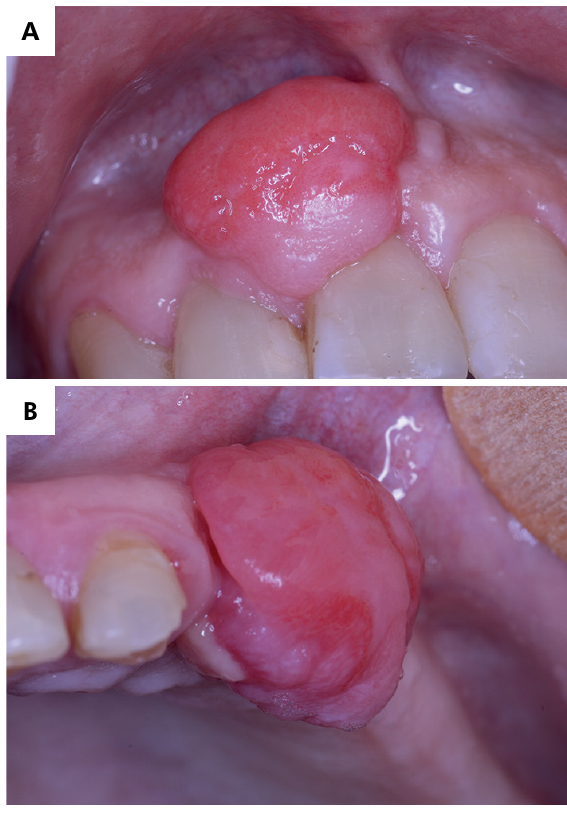
Figure 2. Photomicrographs: bony trabeculae in cell-rich tissue, HE (2A); presence of mineralized tissue around blood vessels, HE (2B) .